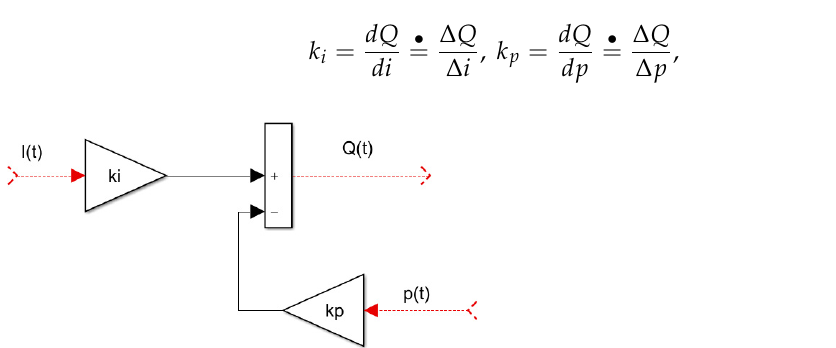
Figure 13. Block diagram of the proportional valve, with red lines being I/O signals in this part of the block diagram.